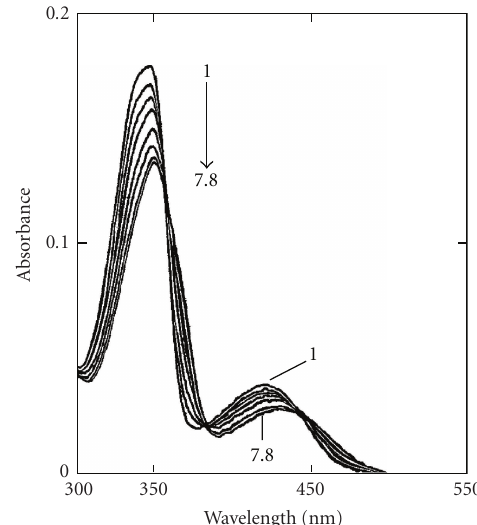
Figure 2: Absorption spectrum (1) of berberine (8 μ M) with increasing concentration up to 117.6 μ M (7) and 125.0 μ M (8) of calf thymus DNA. Reprinted from the Ph.D. Thesis of Bhadra